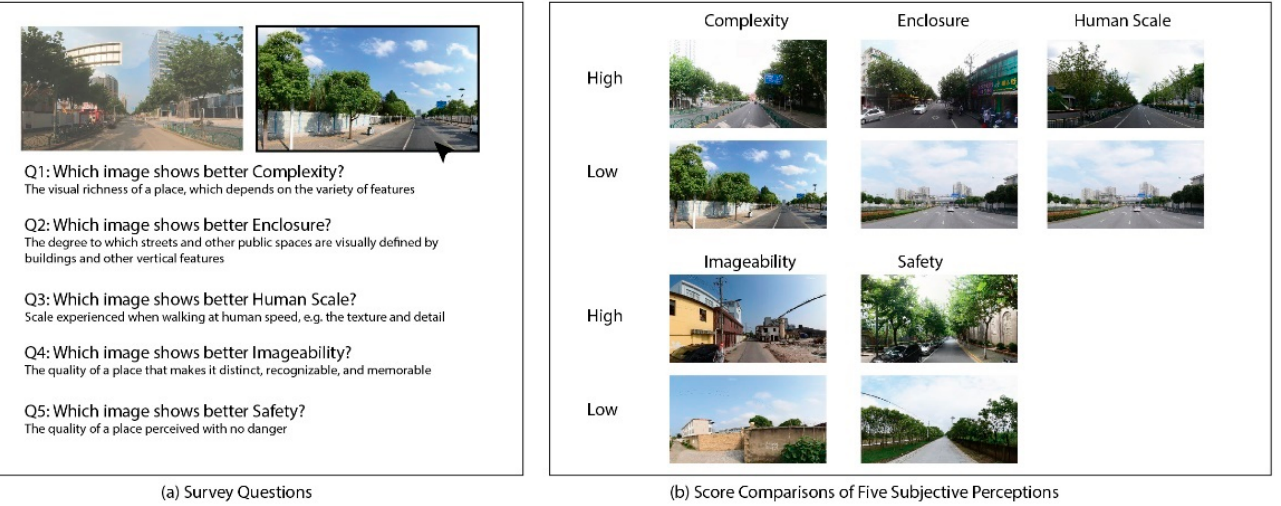
Figure 3. Crowdsourcing online survey to collect subjective opinions from panel of experts. ( a ) The pairwise images regarding five perceptions. ( b ) Pairwise comparison score examples. The five subjective perception scores of the 300 SVIs were used as training labels,